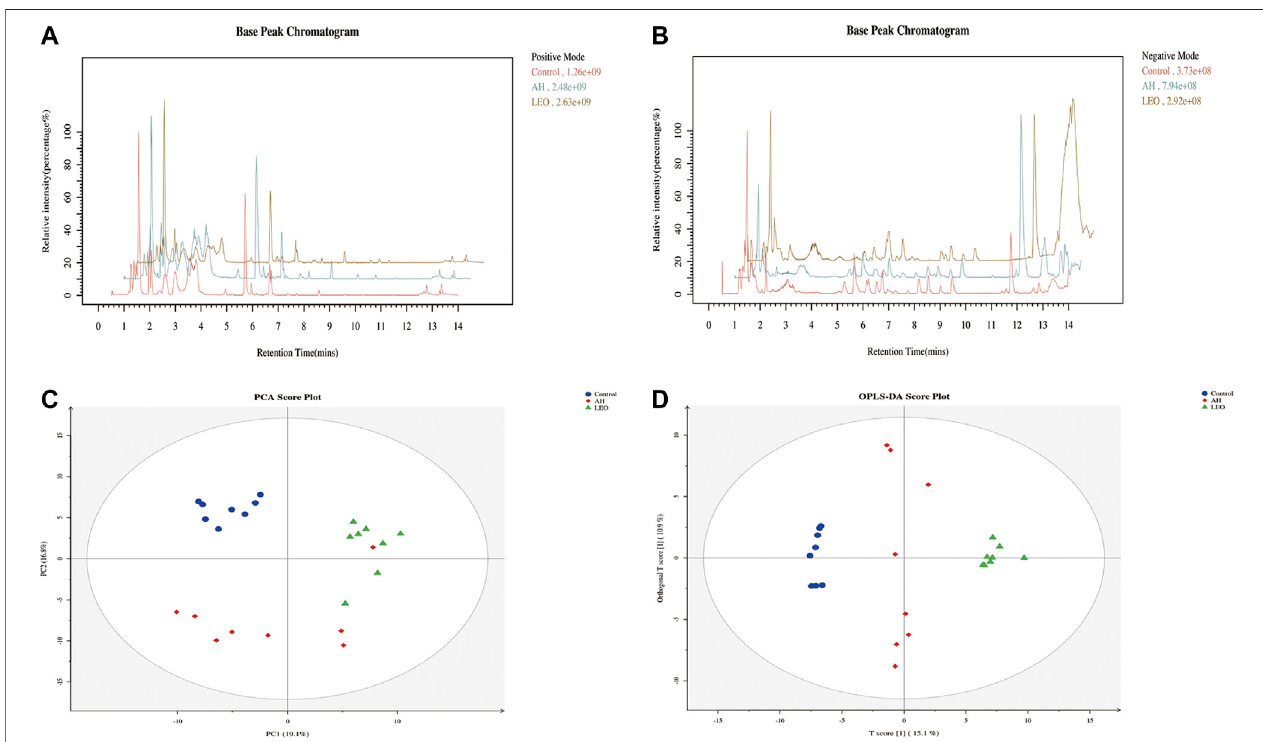
FIGURE 10 | Metabolomic analysis of zebra fi sh larvae samples from control, AH, and LEO groups. (A) Representative base peak chromatogram (BPC) of the control,AH,and LEOgroups inthepositiveionmode. (B) Representative basepeak chromatogram (BPC) ofthecontrol, AH,and LEOgroupsin thenegative ionmode. (C) PCA score plot of metabolites in the positive ion mode. (D) OPLS-DA score plot of metabolites in the positive ion mode.